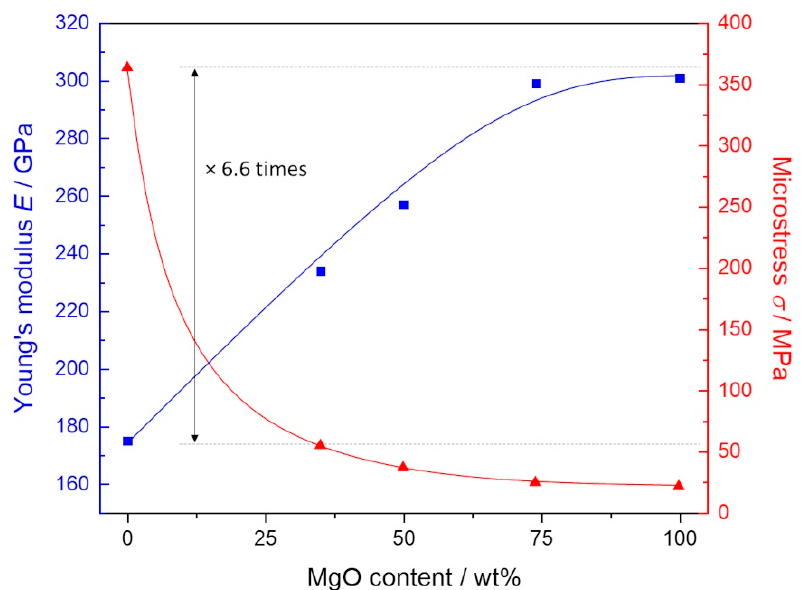
Figure 5. Mechanical properties of ZrO 2 /MgO ceramics showing an increasing Young‘s modulus ( E ) and decreasing microstress ( σ ) followed by increasing MgO content. Microstress of 100 % ZrO 2 is ⁓ 6.6 times larger than that of ZrO 2 /MgO ceramic.